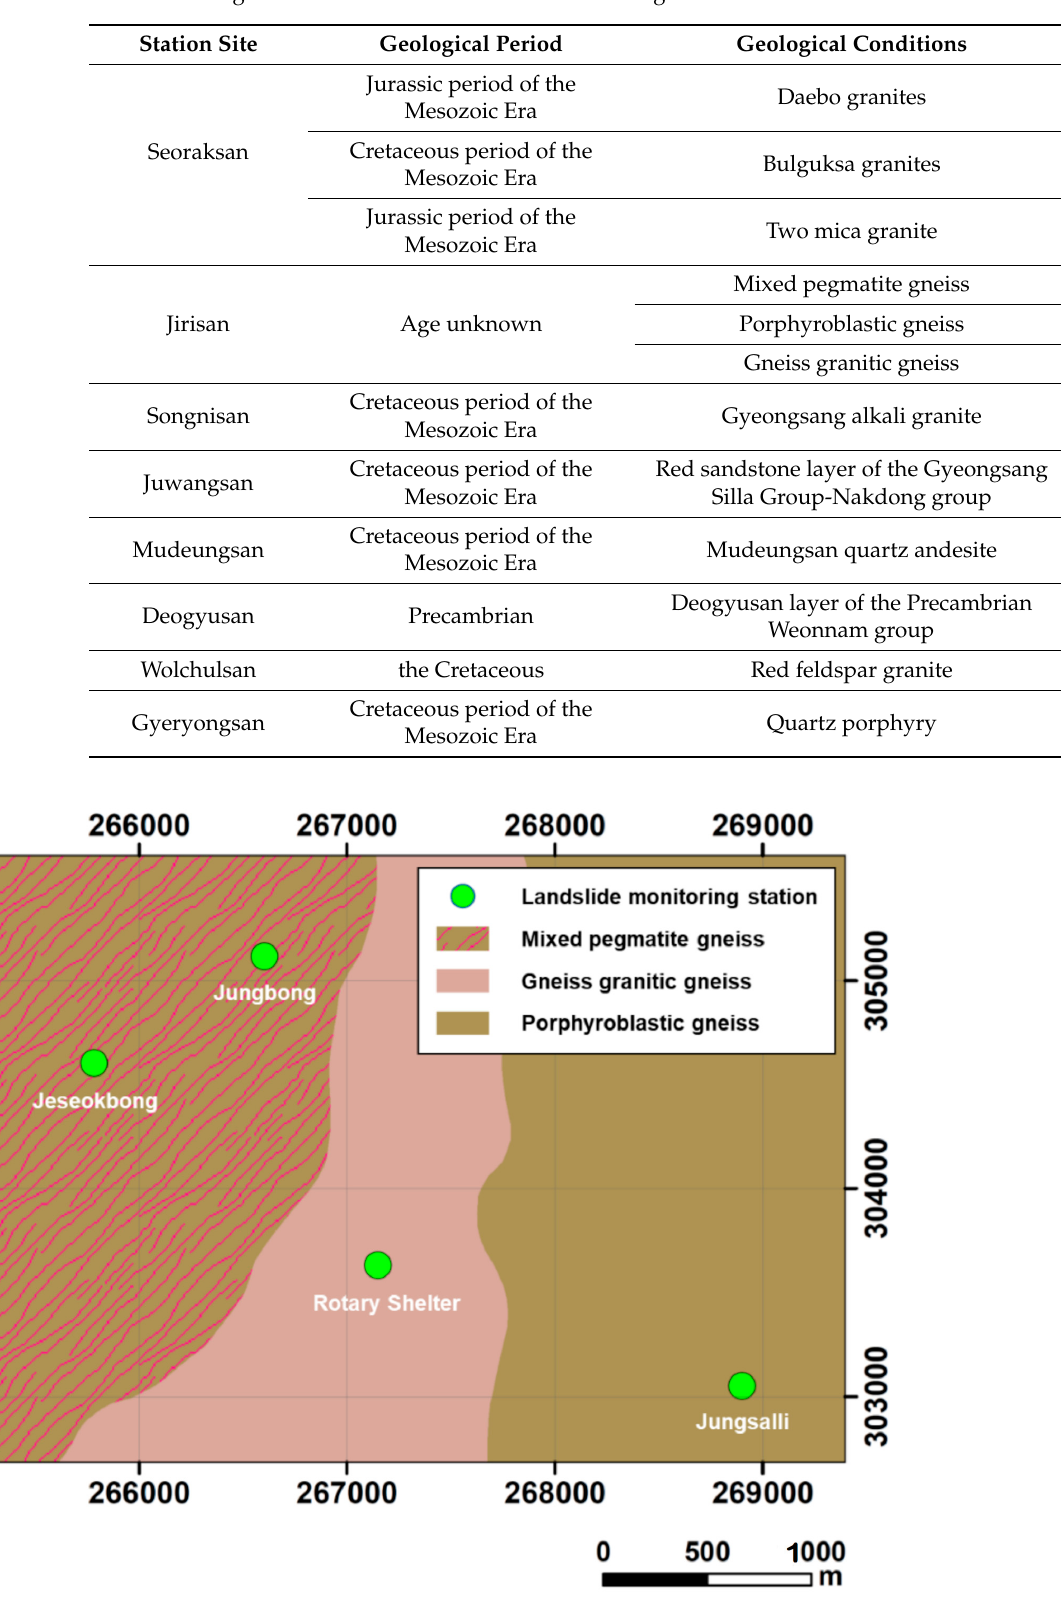
Figure 3. Geological conditions of four landslide monitoring stations in Jirisan National